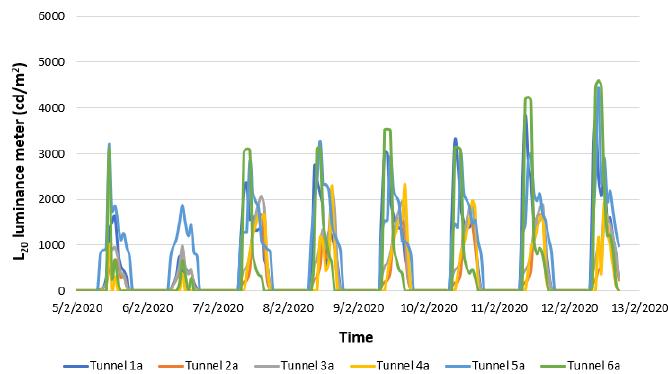
Figure 5. Signal from SCADA due to daylight variation (eight days) for the examined tunnels in the lanes leading to Athens (Tunnels 1a, 2a, 3a, 4a, 5a, and 6a).